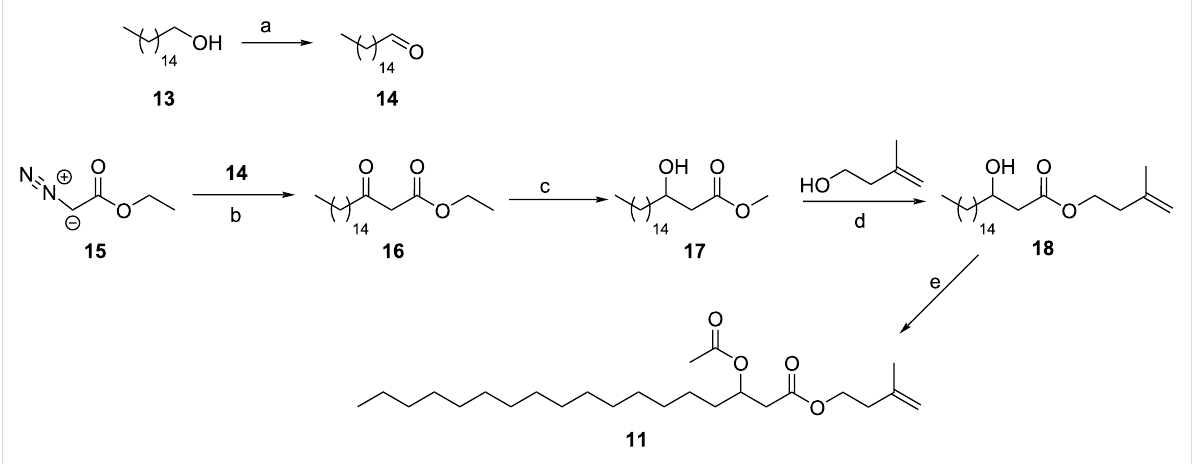
Scheme 3: Synthesis of isoprenyl 3-acetoxyoctadecanoate ( 11 ). a) IBX, EtOAc, 60 °C, 3.15 h, 99%; b) SnCl 2 , CH 2 Cl 2 , rt, 70%; c) NaBH 4 , 12 h, 98%; d)